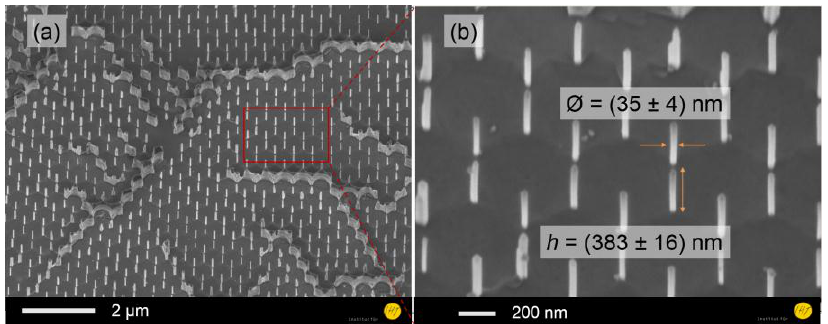
Figure 5. SEM images depicting ( a ) ~35 nm GaN nanowire arrays with density of 9.23 × 10 8 cm −2 and ( b ) smoothened sidewall surfaces after wet etching, in which their diameter can be precisely controlled by simply adjusting the etch